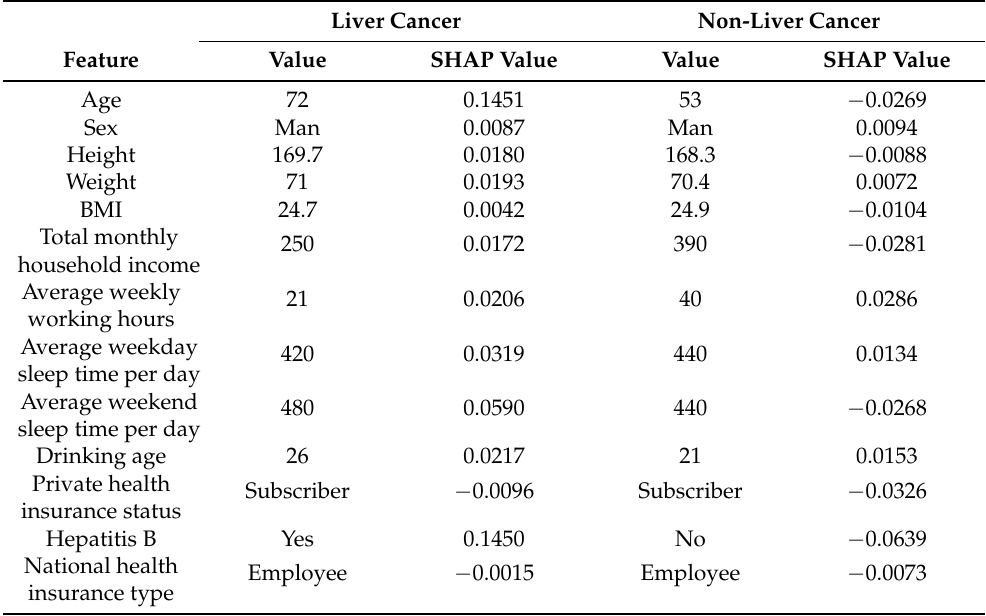
Table 14. Example of SHAP analysis for observations of the liver cancer risk association model. Liver Cancer